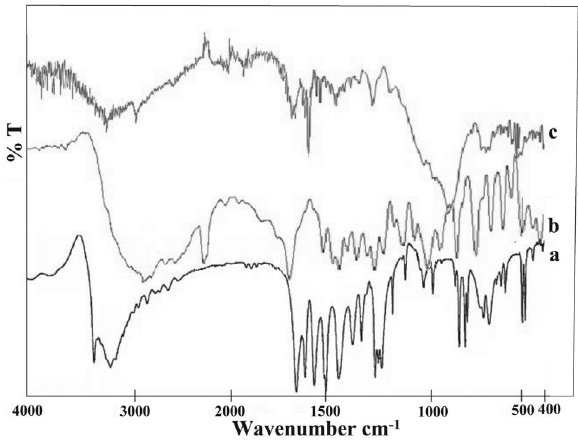
Figure 3. ATR-FTIR spectra of (a) PA, (b) IB, and (c) COAM 1